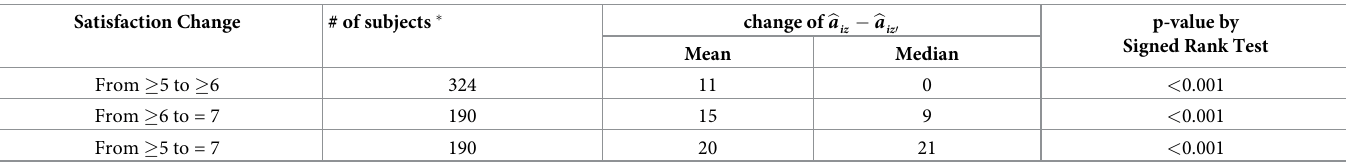
(cid:0) b a . iz iz 0